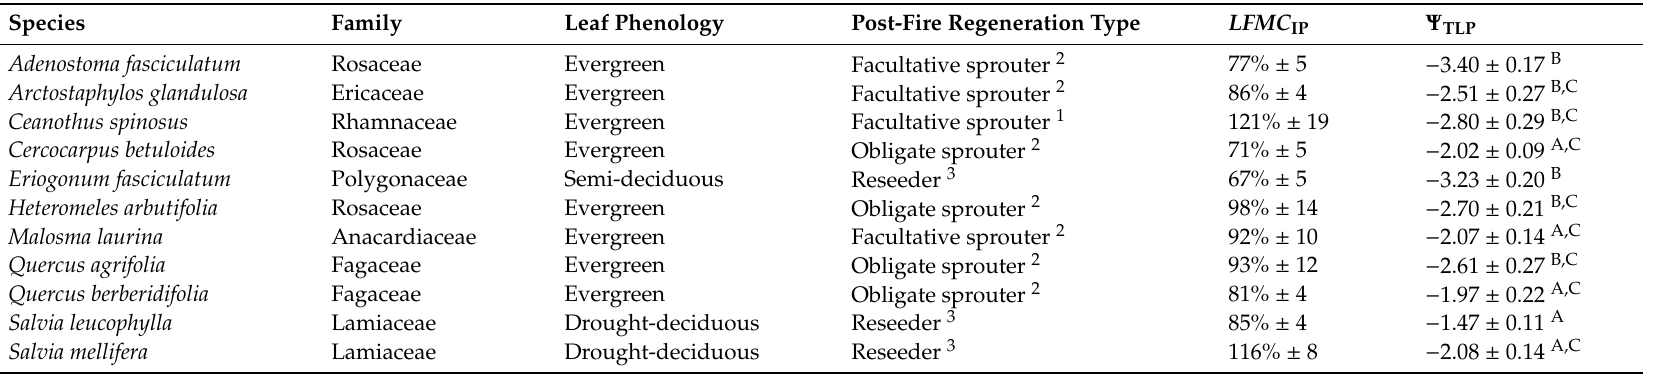
Table 1. Study species, including family, leaf phenology, post-fire regeneration type, the live fuel moisture content inflection point ( LFMC IP ) ± standard error, and